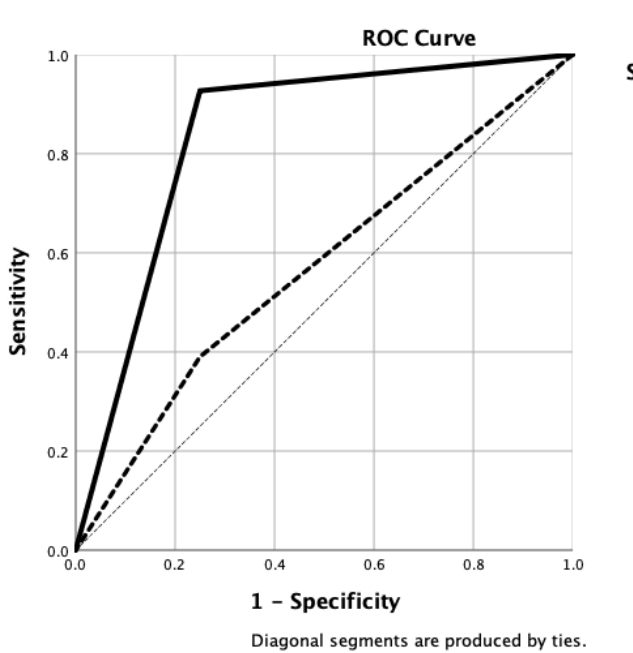
Figure 4. Drawn ROC curves for [ 18 F]FCH PET/CT (AUC = 0.84) versus clinical ultrasonography (AUC = 0.57) diagnostic accuracies in detecting mild primary hyperparathyroidism.